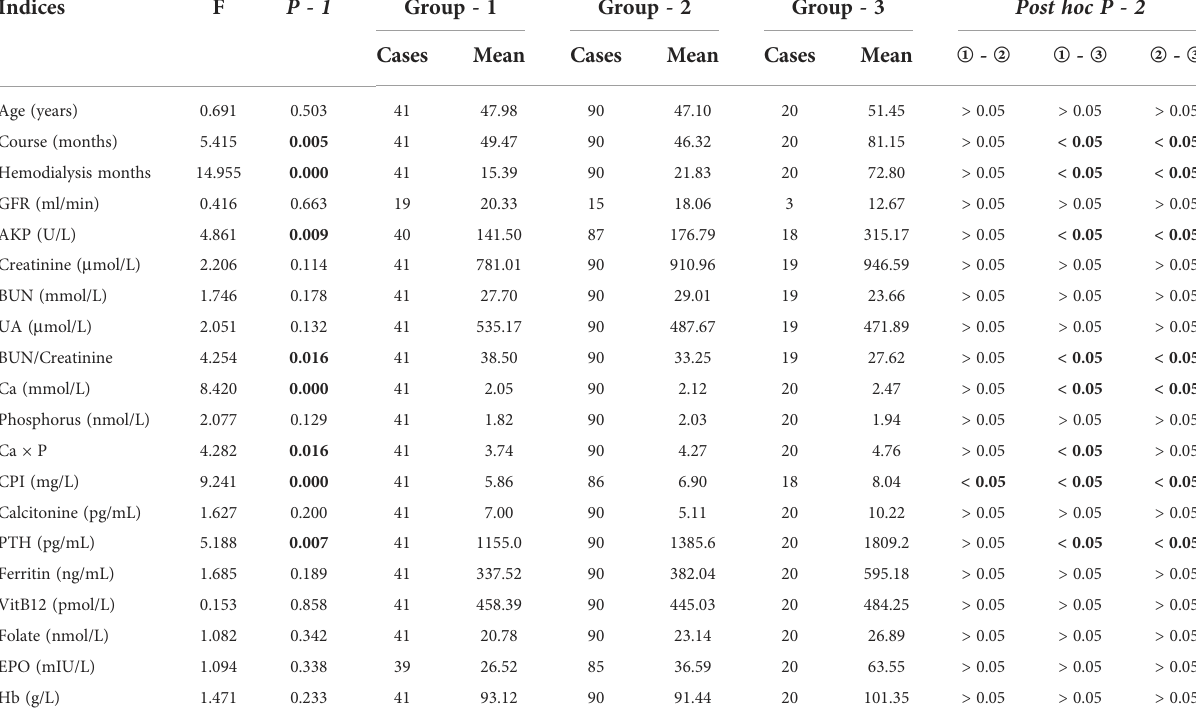
TABLE 4 The comparison of some indices among three qualitative groups during delayed